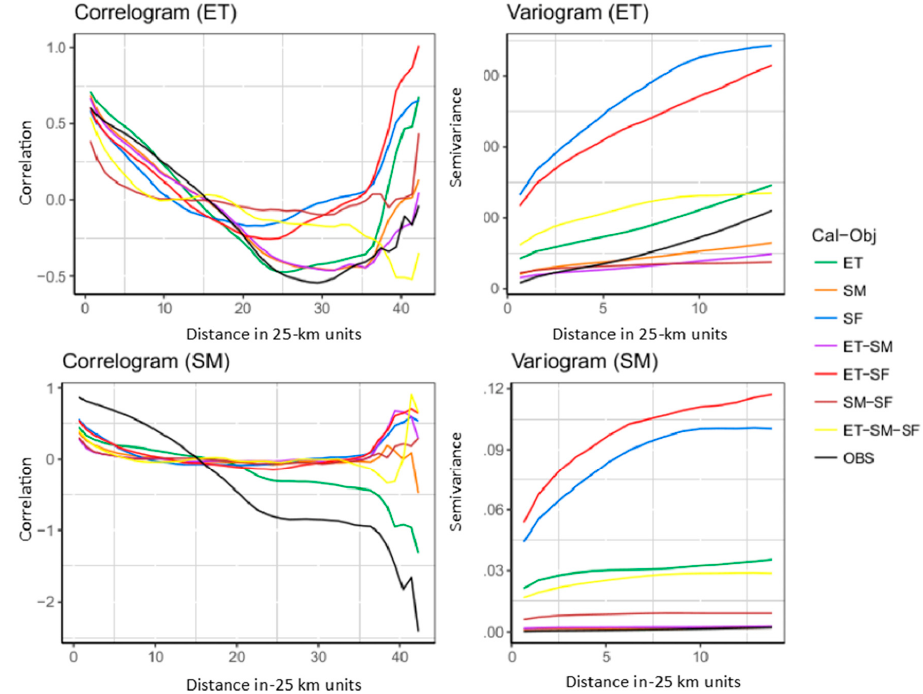
Figure 4. Spatial plots of scaled RMSE values of ET (top panel) and SM (bottom panel) when the Noah-MP model is calibrated with (1) ET, (2) SM, (3) SF, (4) ET–SM, (5) ET–SF, (6) SM–SF, and (7) ET–SM–SF as calibration objectives.